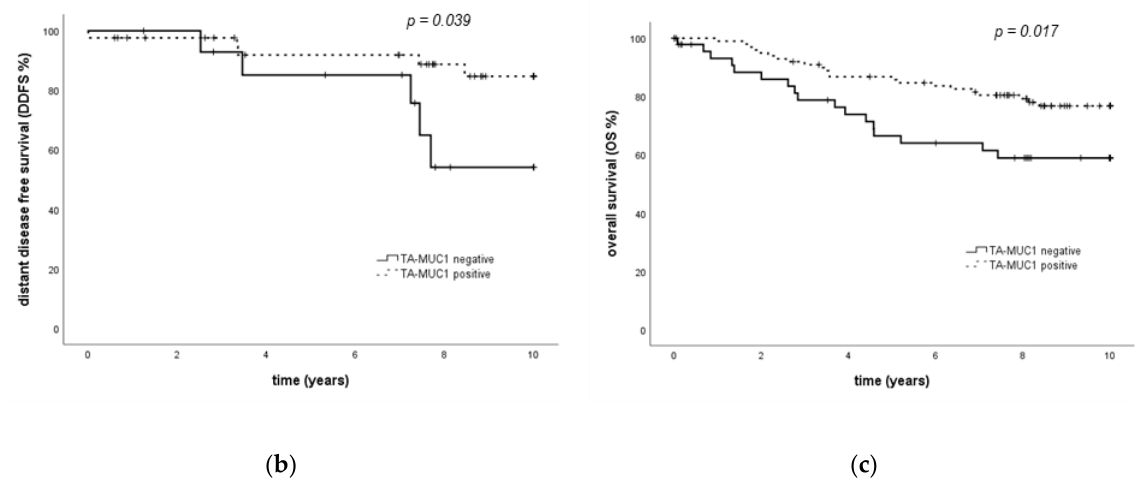
Figure 5. Clinical outcome of breast cancer patients regarding TA-MUC1 expression and in subgroups defined by the combination of TA-MUC1 and Siglec-8 expression. Kaplan–Meier analysis of DDFS shows an association of borderline significance between DDFS and TA-MUC1 expression in the overall cohort ( a ). In patients with low Siglec-8 expression, TA-MUC1 positivity is associated with an improved DDFS ( b ). However, in patients with high Siglec-8 expression, TA- MUC1 positivity is associated with an improved OS ( c ). TA-MUC1 = tumor-associated mucin-1. DDFS = distant disease-free survival. OS = overall survival. IRS = immune reactivity